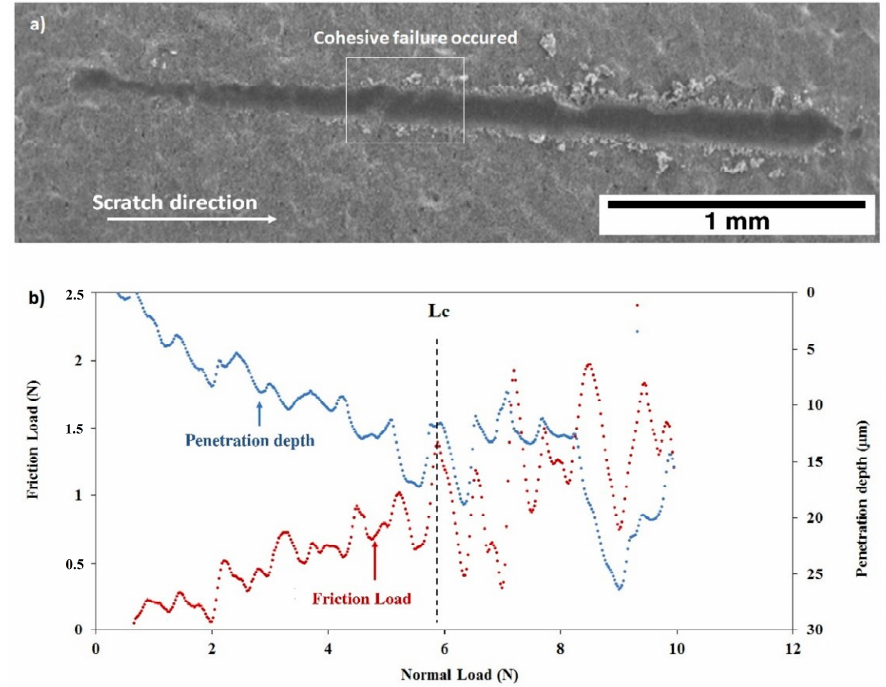
Figure 16. Scratch test of the C30 coating after thermal treatment: ( a ) SEM micrograph of the scratch and ( b ) friction force and penetration depth as a function of normal load.